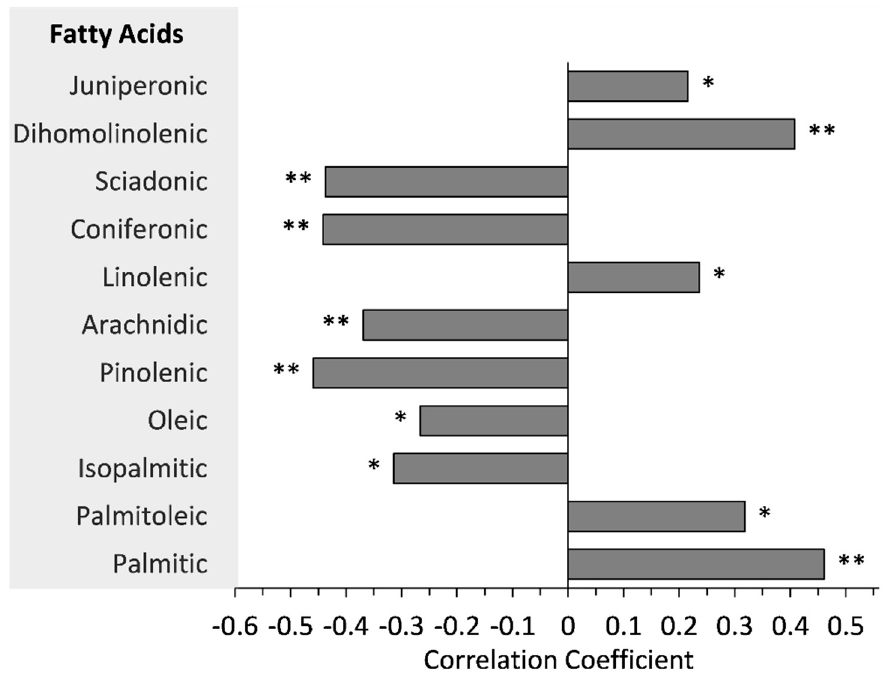
Figure 7. Significant correlation coefficients of fatty acids compared to needle retention in balsam fir. An * indicates 1 − 5% signi fi cance and ** indicates less than 1% signi fi cance. n = 100 for each.